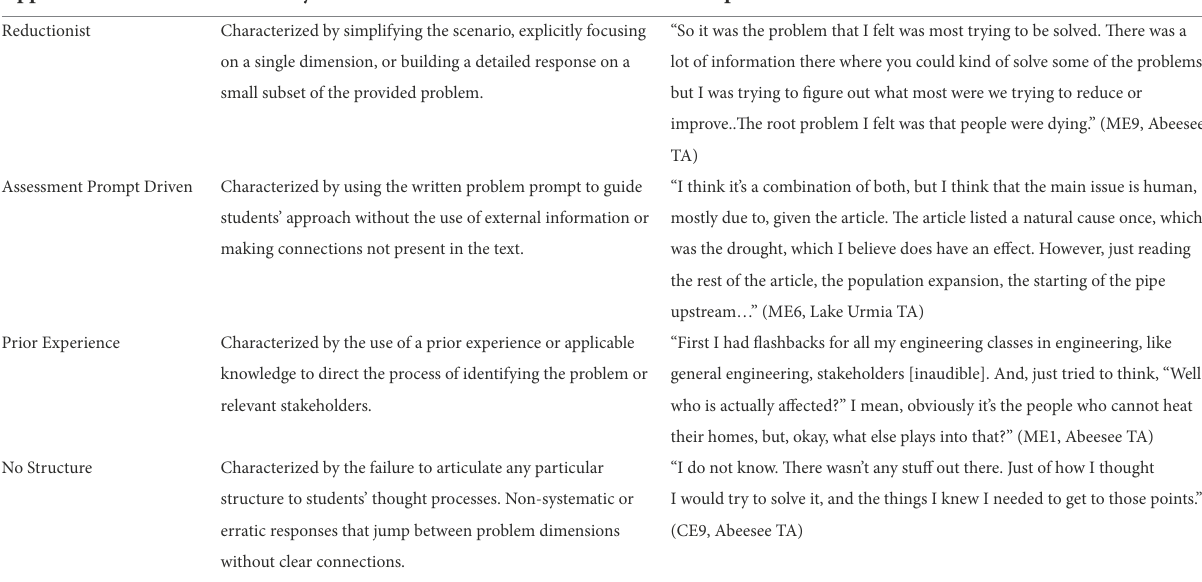
TABLE 1 Summary of problem solving